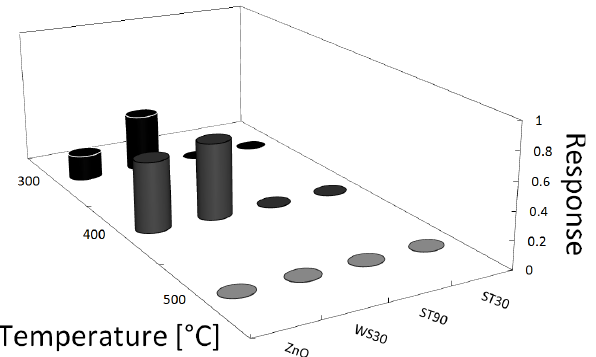
Figure 9. Responses of the sensors to 4ppm of NO 2 at three di ff er- ent